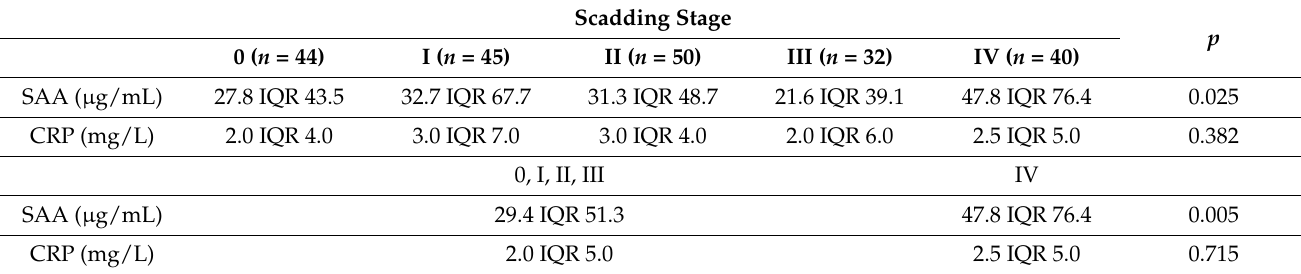
Table 4. SAA levels among sarcoidosis patients with different Scadding stages. Scadding